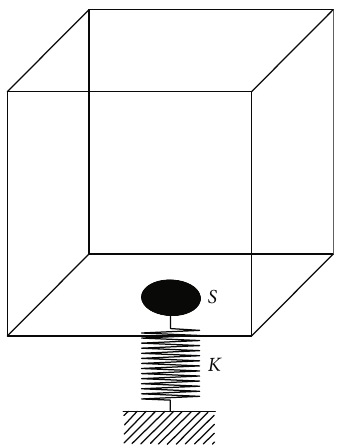
Figure 3: Vibration model of perilous